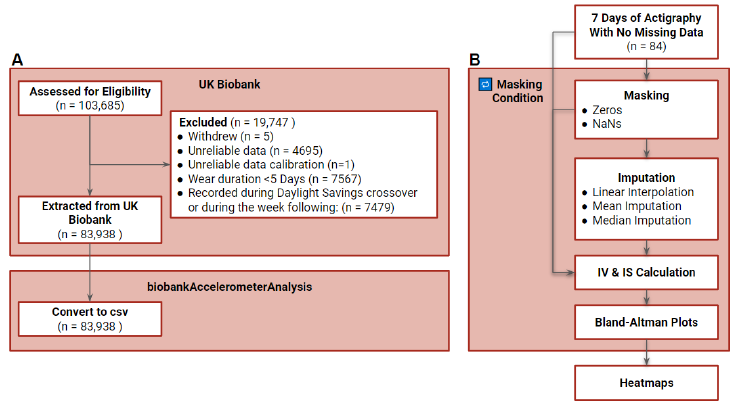
Figure 5. Consort Diagram. In total, 103,685 files were assessed for eligibility, of which 19,747 were excluded, resulting in 83,938 accelerometer files ( A ). A random subset (N = 84 files, 0.01% of extracted sample) of individuals with at least 7 days of data without missing data were subjected to masking, imputation, IV and IS calculation ( B ).